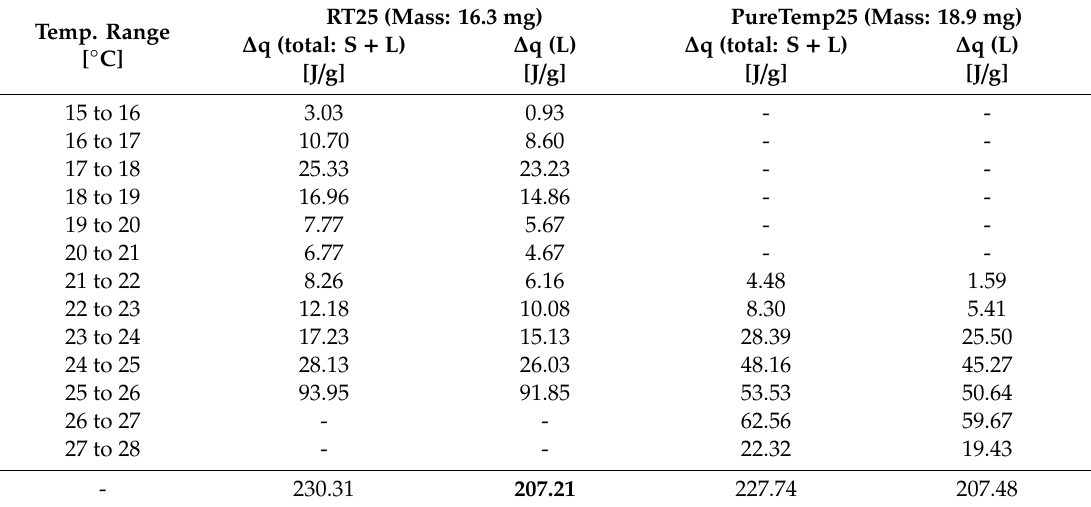
Table 4. Stored heat values (sensible = S, latent = L and total = S + L) of RT 25 and PureTemp 25, as shown in Figures 17 and